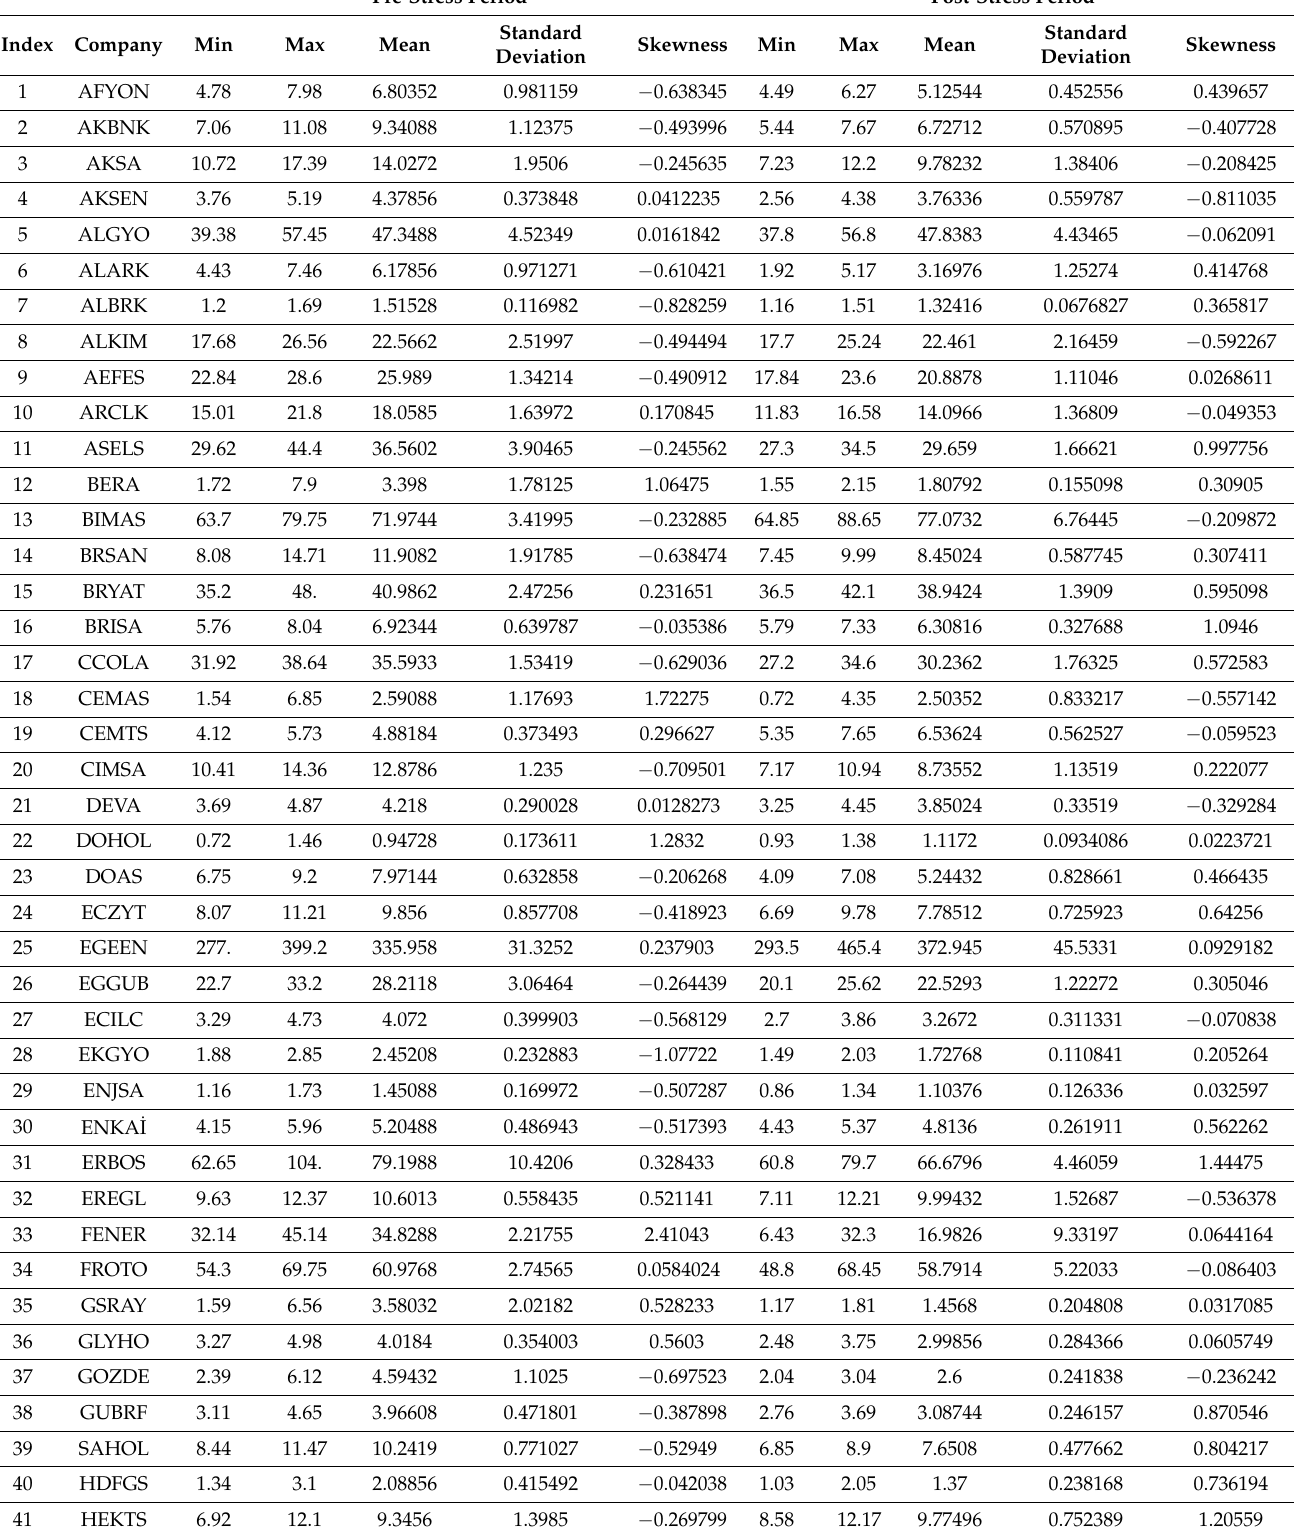
Table A1. Descriptive statistics for the 2018 economic period data